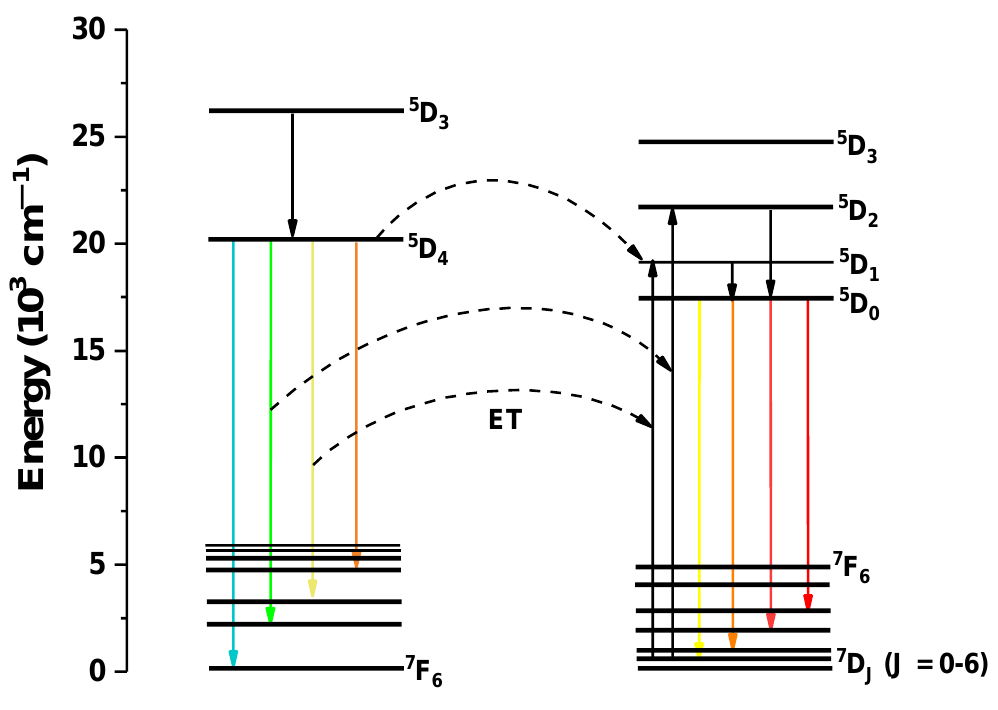
Figure 8. Schematic of Tb 3+ and Eu 3+ energy levels indicating the energy transfer processes in the SrWO 4 phosphors.